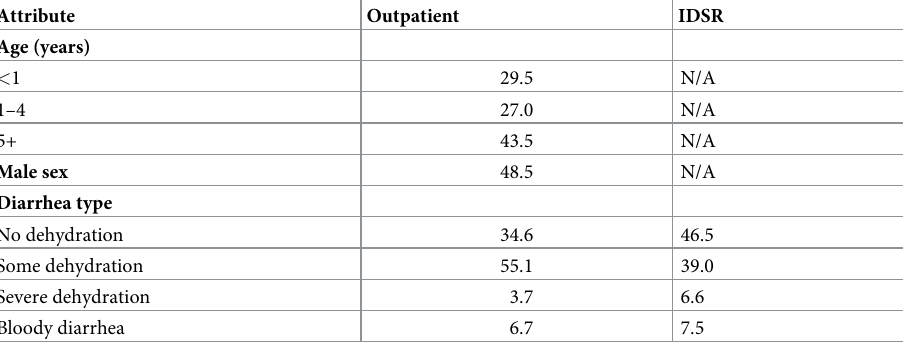
Table 2. Demographic distributions of outpatient diarrhea cases and IDSR under-5 diarrhea cases in Chobe District. Attribute Outpatient IDSR